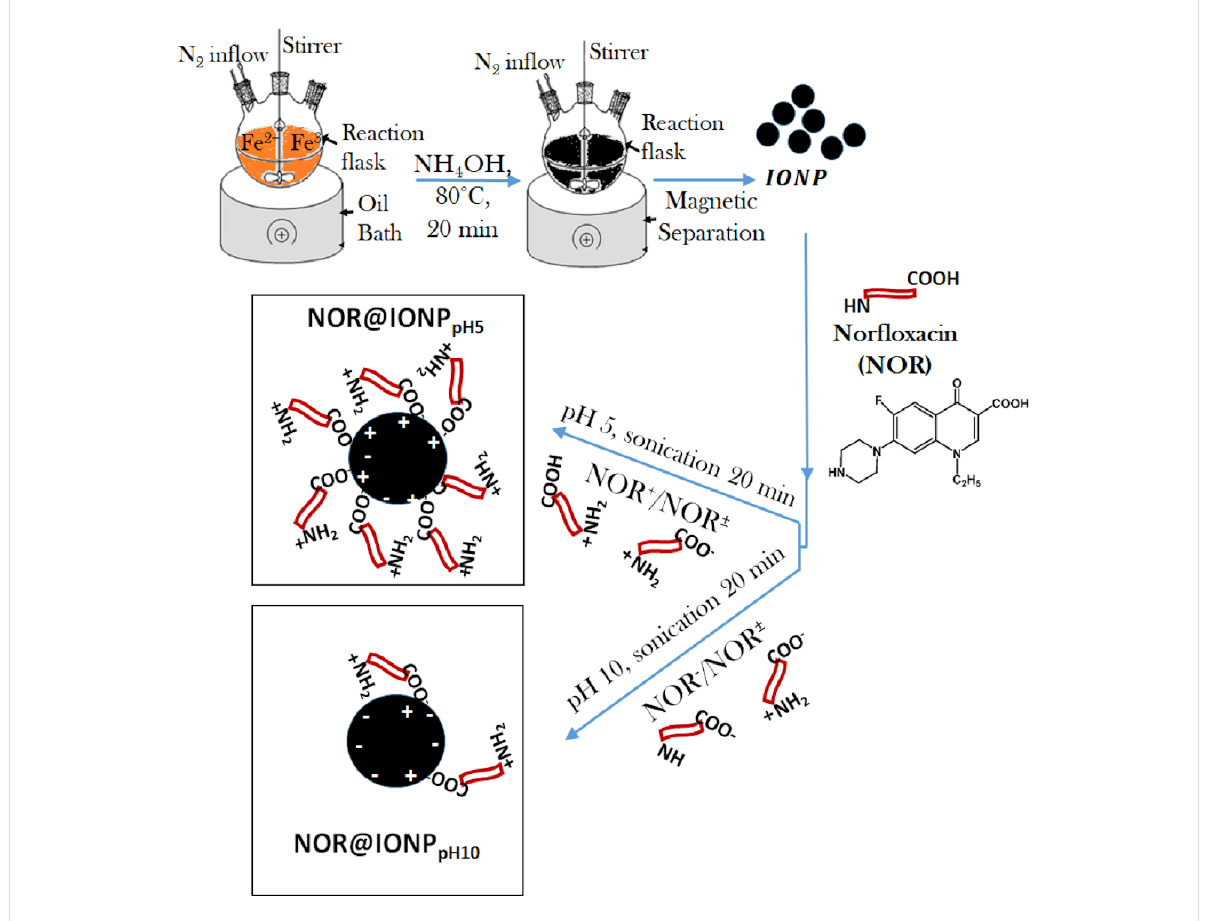
Figure 1: A representation of the iron oxide nanoparticle synthesis followed by the steps for drug loading. NOR@IONP pH5 are particles coated with drug at pH 5, showing higher drug loading. NOR@IONP pH10 are particles coated with drug at pH 10, showing lower drug loading.